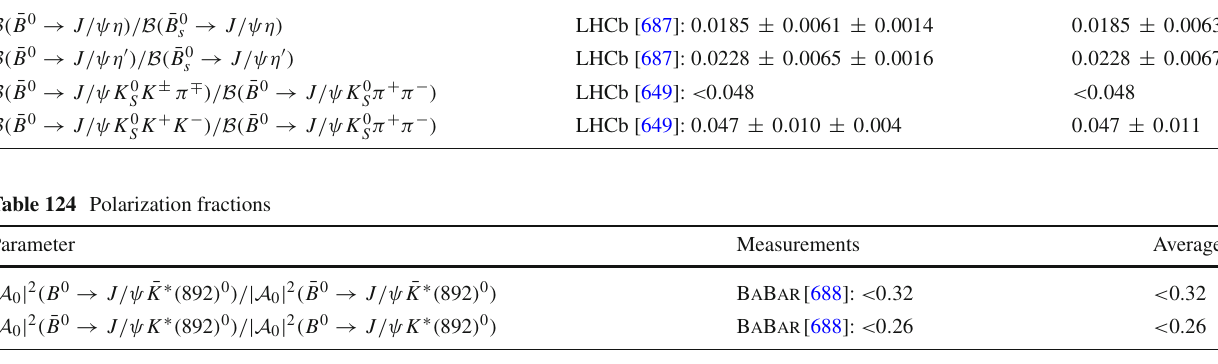
Parameter Measurements